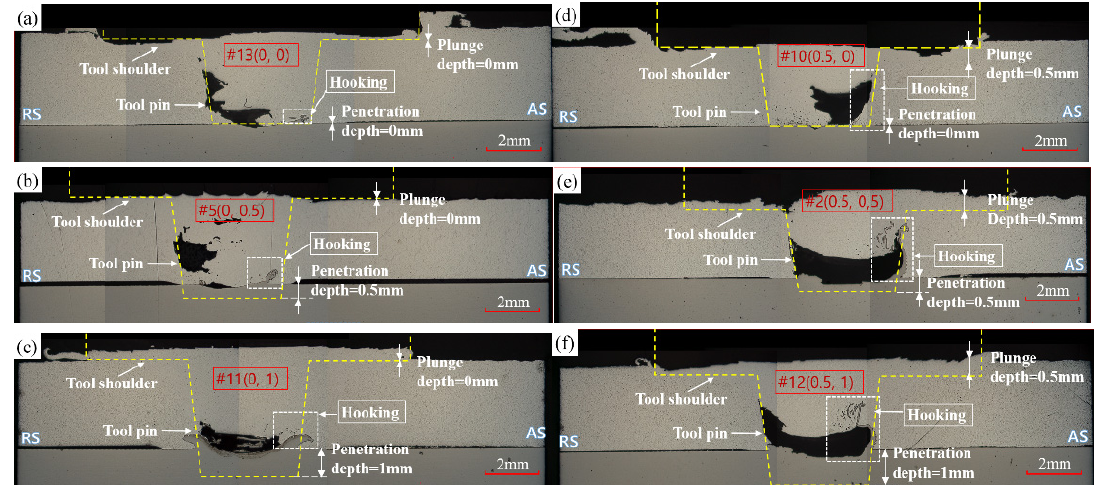
Figure 9. Comparison of the plunge depth and penetration depth on the interface structure. ( a ) (0 mm, 0 mm) (test No. 13); ( b ) (0 mm, 0.5 mm) (test No. 5); ( c ) (0 mm, 1 mm) (test No. 11); ( d ) (0.5 mm, 0 mm) (test No. 10); ( e ) (0.5 mm, 0.5 mm) (test No. 2) ( f ) (0.5 mm, 1 mm) (test No. 12).